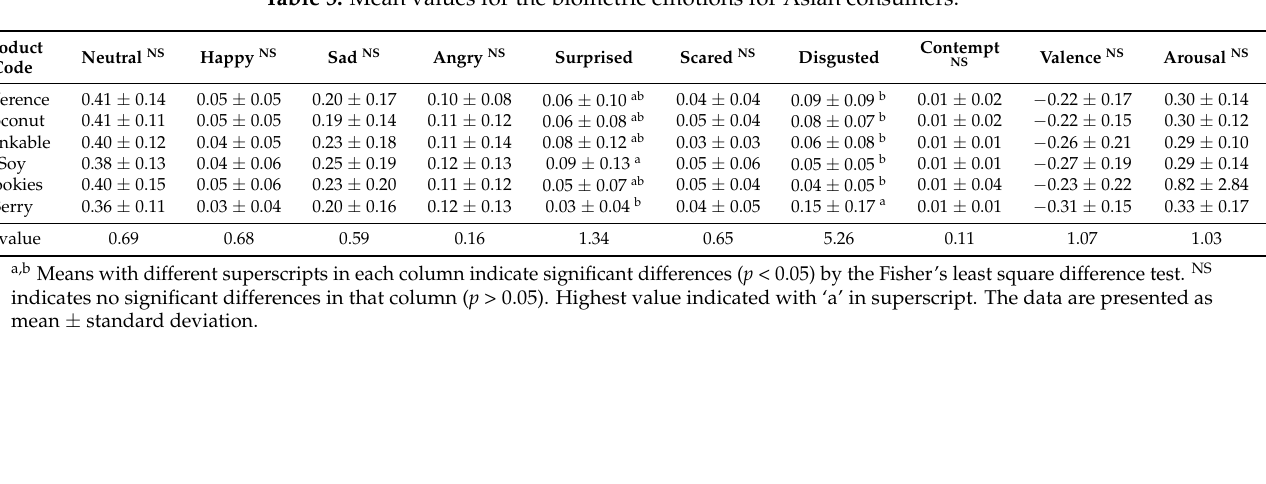
Table 5. Mean values for the biometric emotions for Asian consumers.